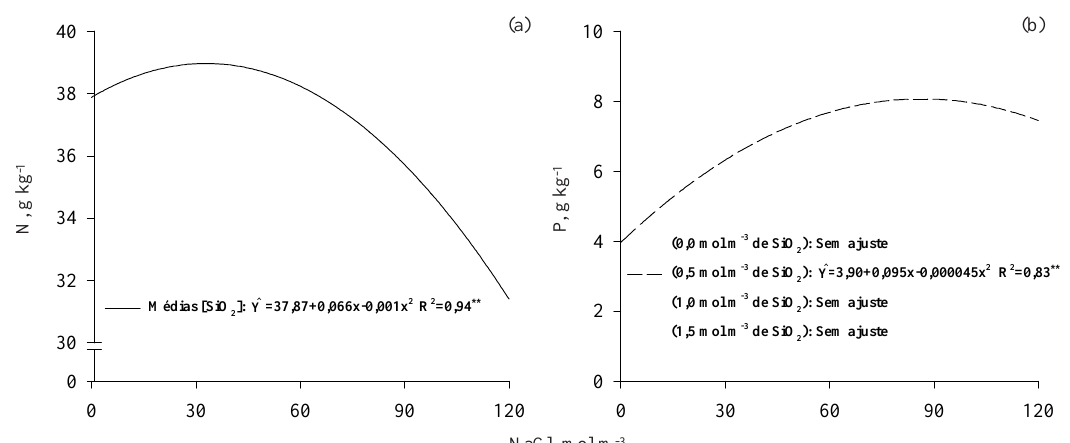
Figura 1. Teores de N (a) e P (b) nas folhas de moringa, considerando a concentração de NaCl, e de NaCl na solução, respectivamente. e SiO 2